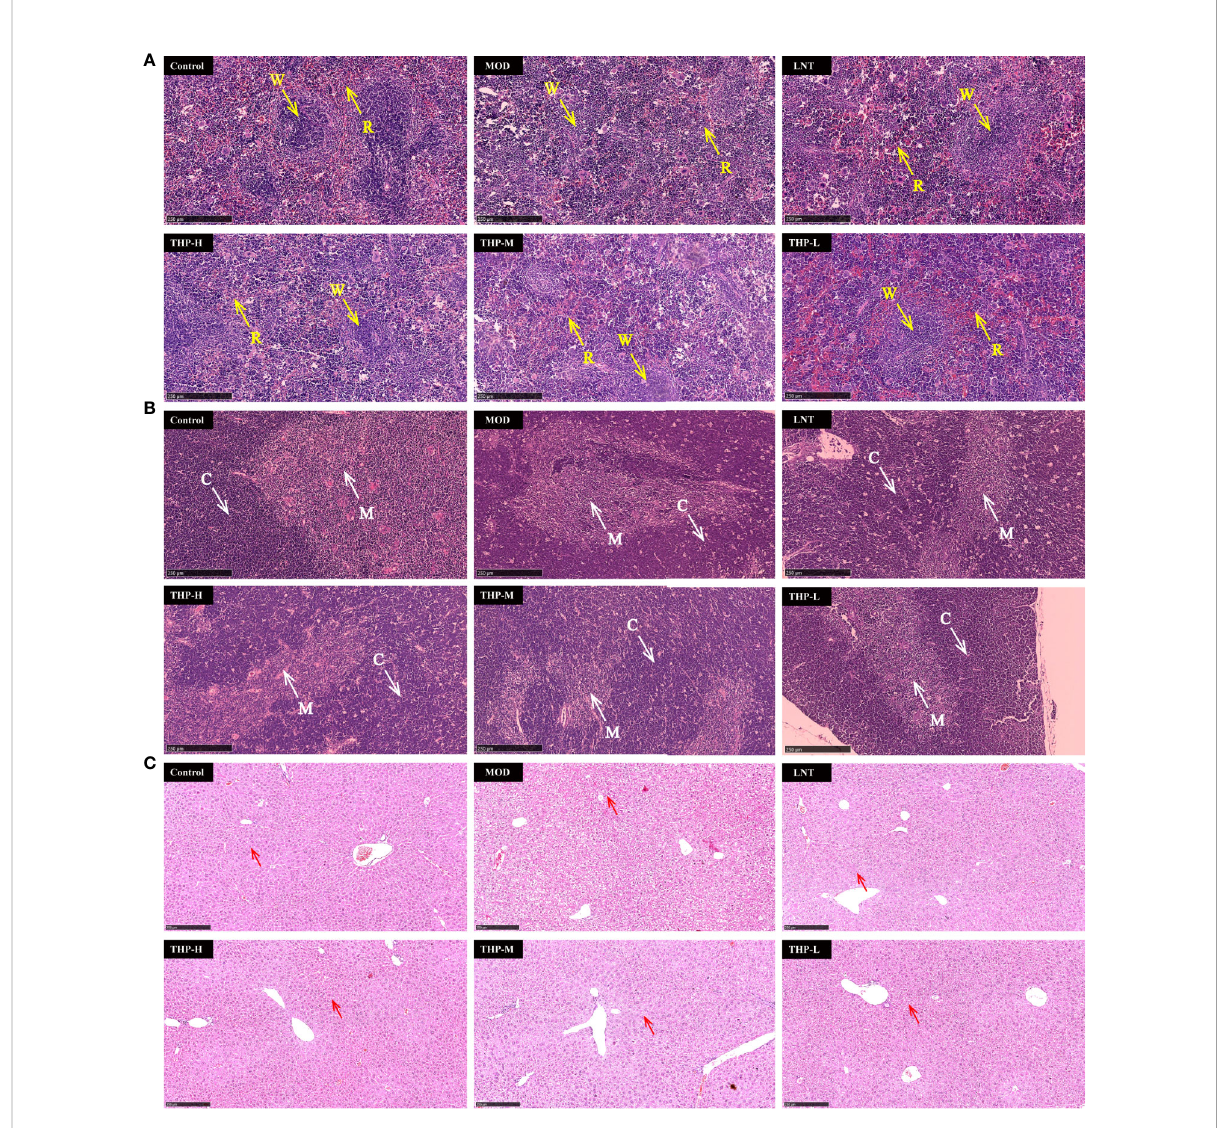
FIGURE 10 Effect of THP on the histopathology of the spleen, thymus and liver. (R, red pulp. W, white pulp. C, cortex. M, medulla. Red arrow: Kupffer cell) Scale bar: 250 m m. (A) HE staining of the spleen, (B) HE staining of the thymus, (C) HE staining of the